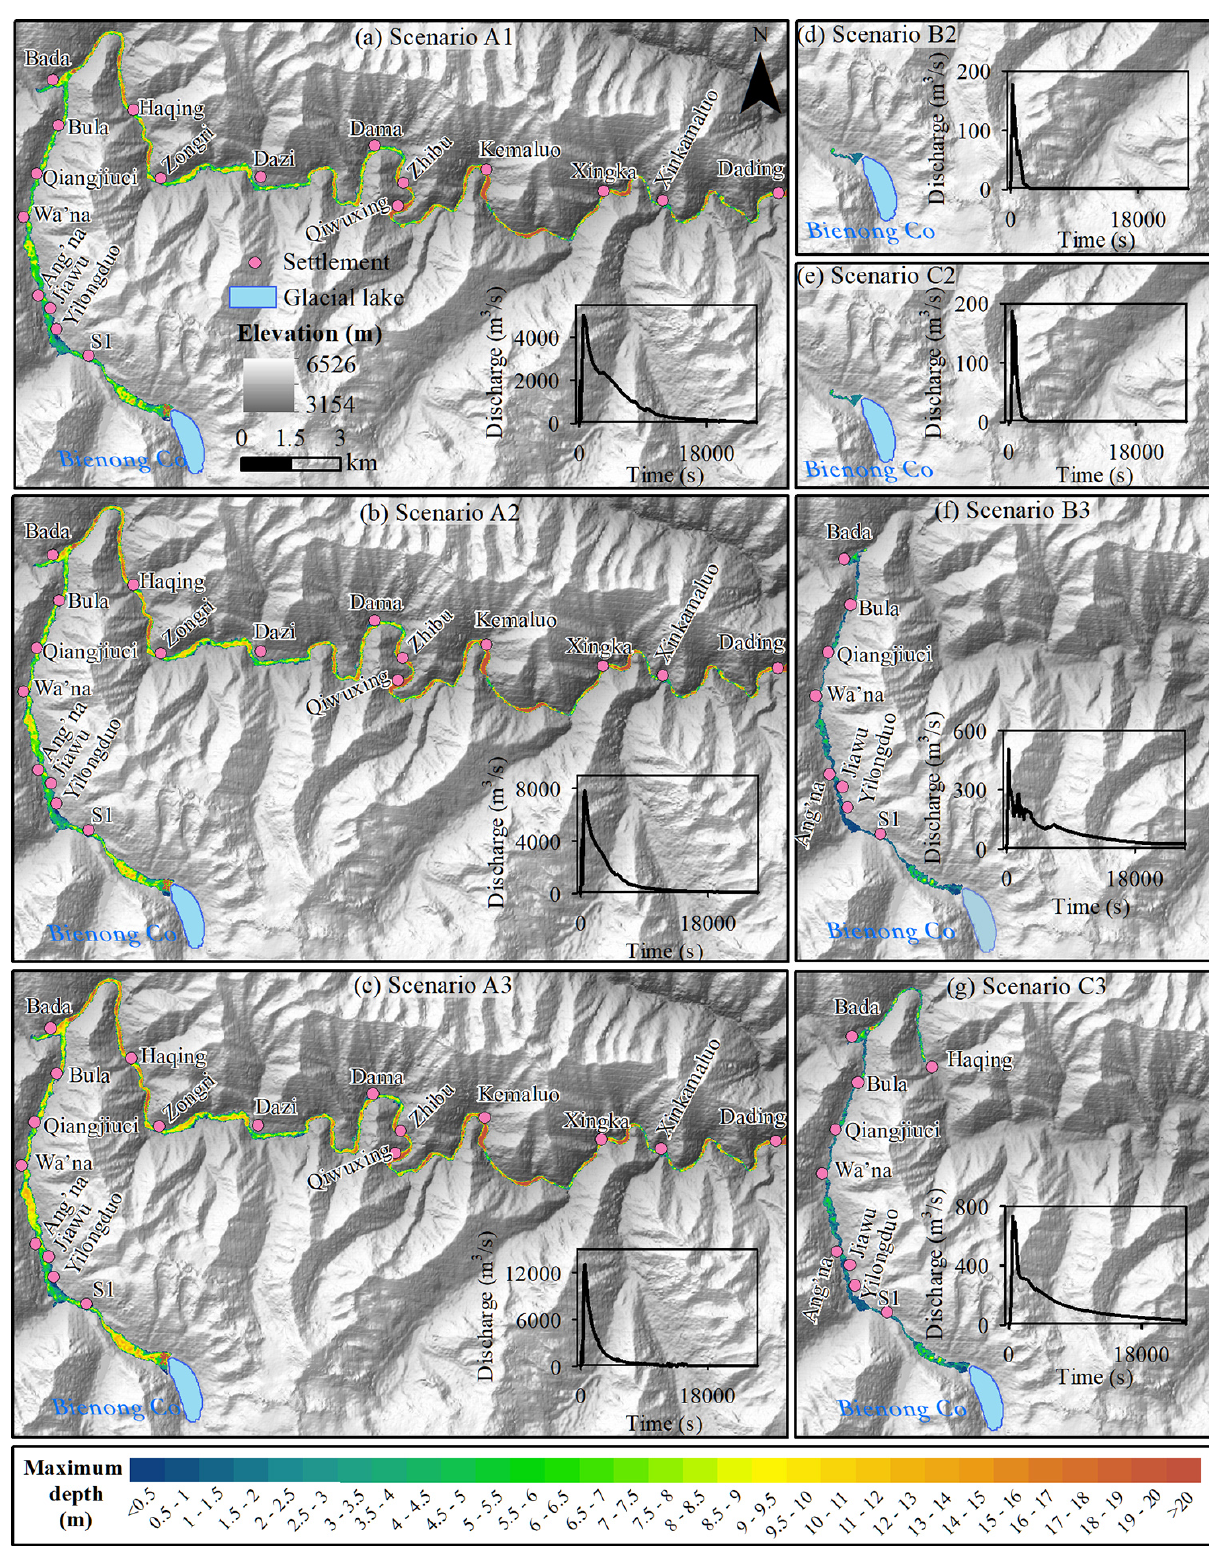
Figure 11. Propagation of flood water downstream and the time series of discharge at the breach outlet (inset) for different scenarios.